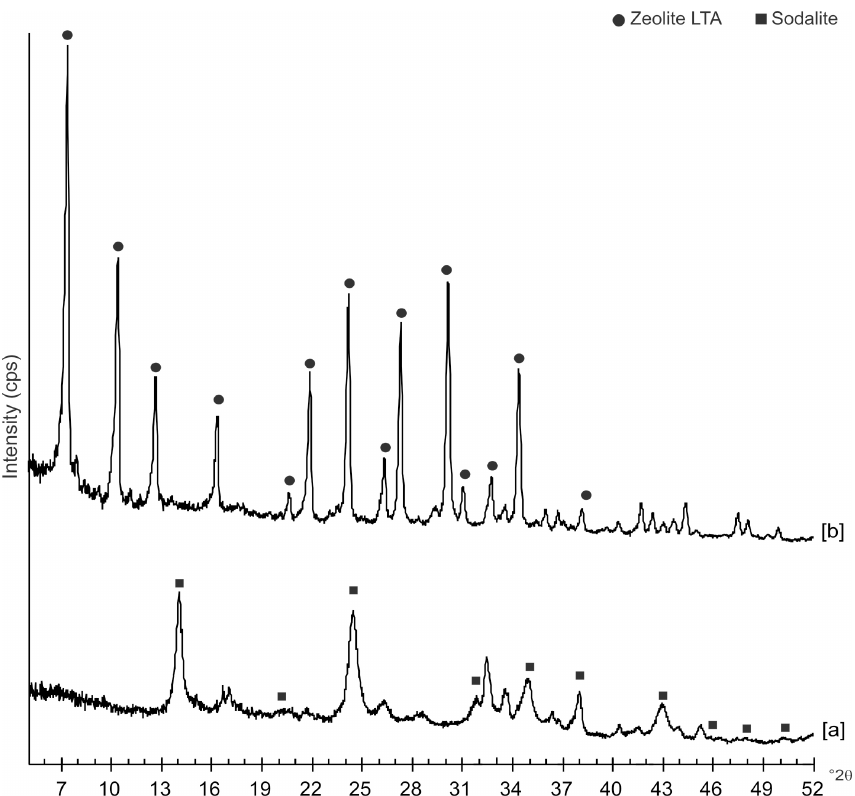
Figure 2. XRD profiles of sample analyzed: [a] 6 months after the synthesis by hydrothermal process with ultrasonic irradiation and [b] 12 months after the synthesis by conventional hydrothermal treatment.